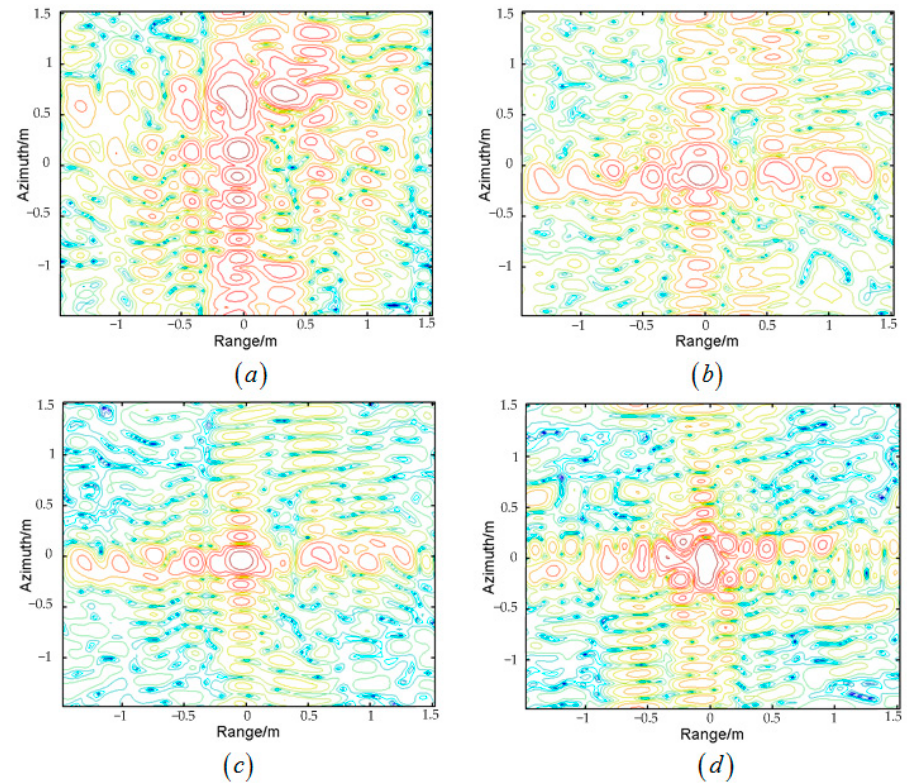
Figure 18. The contour map of targets ( a ) Point a in Figure 17 without any MOCO. ( b ) Point a ′ in Figure 17 refocused by MD. ( c ) Point a ′′ in Figure 17 refocused by MD and PGA. ( d ) Point a ′′′ in Figure 17 refocused by PGA directly.